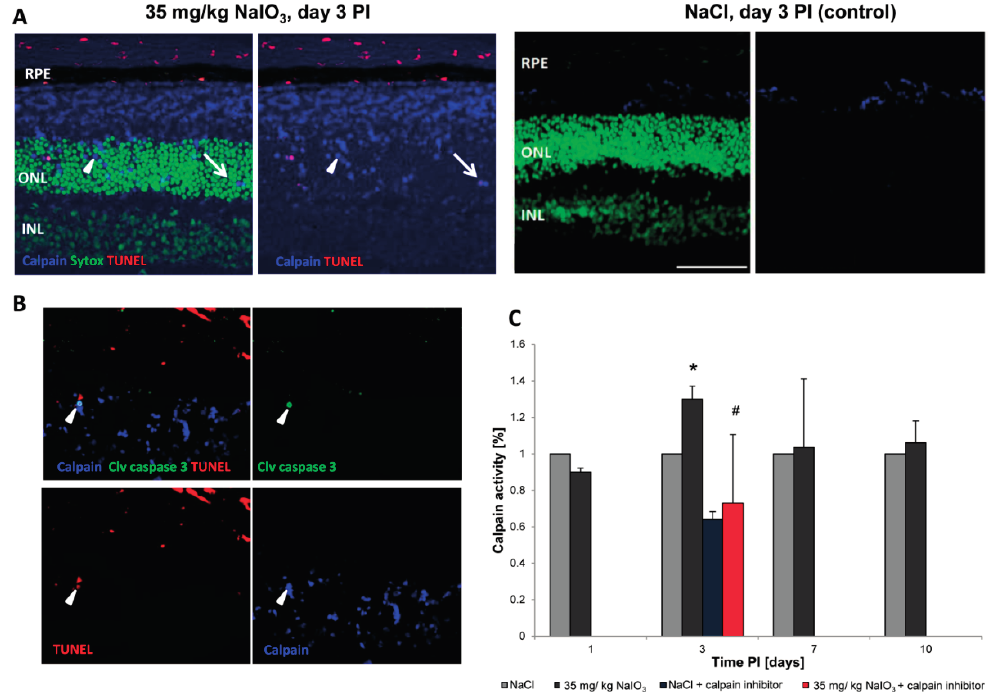
Figure 4. Caspase-independent cell-death mechanisms are also involved in PRC death in response to NaIO 3 . ( A ) Calpain is activated in degenerating PRCs. At day 3, calpain activity (blue, arrowhead) was detected exclusively in the ONL ( left panel ). No activity was detectable in the control sections ( right panel ). Individual calpain-expressing cells were also TUNEL-positive (arrow), representing a late stage cell death; ( B ) Individual TUNEL-positive PRCs (red) that expressed activated calpain (blue) were also caspase-3 (green) positive (arrowhead). Scale bar = 50 μ m; ( C ) A significant upregulation of calpain activity was measured in retinal lysates of NaIO 3 -treated animals at day 3 post-injection ( * p < 0.05). This upregulation could be abolished if lysates were incubated with a calpain inhibitor prior to exposure to the substrate (# p <